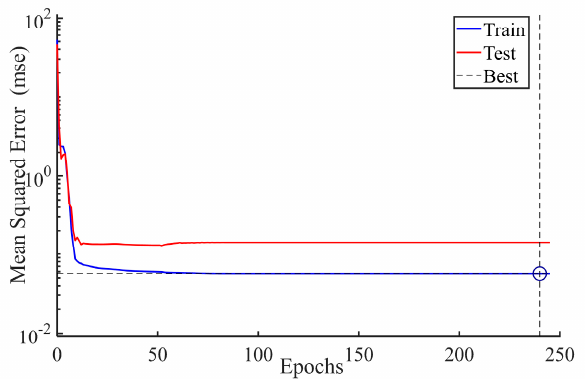
Figure 8. Error curve of the RBF-based aerodynamic model.